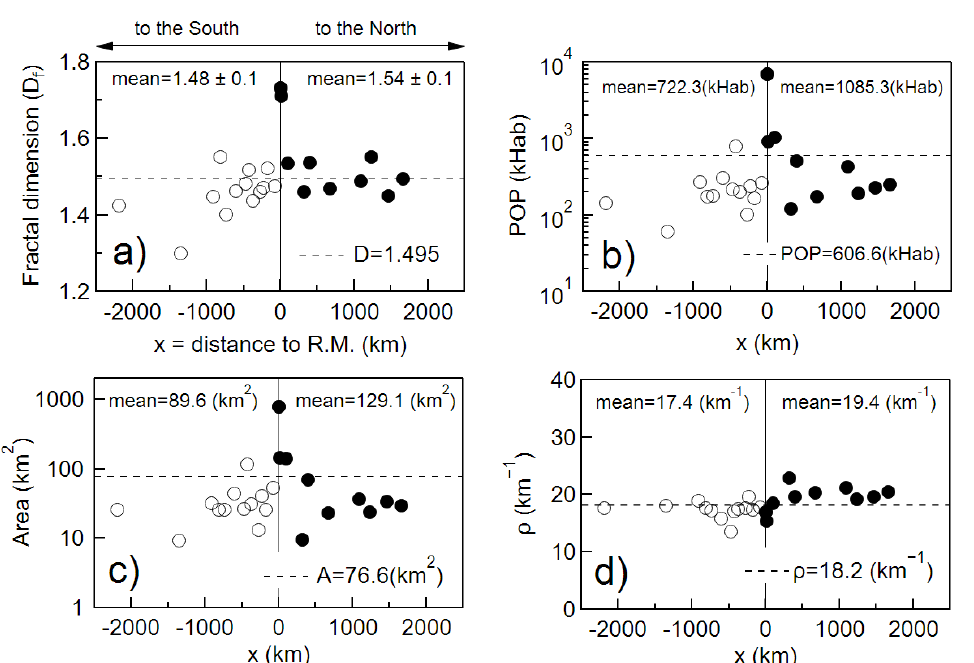
Figure 11. Longitudinal distribution of different metrics ( x = 0 for RM.; x > 0 for northern cities and x < 0 for southern cities). ( a ) D f , ( b ) POP (measured in thousands of people hHab ), ( c ) A and ( d ) ρ . Global averages were included for reference (dashed